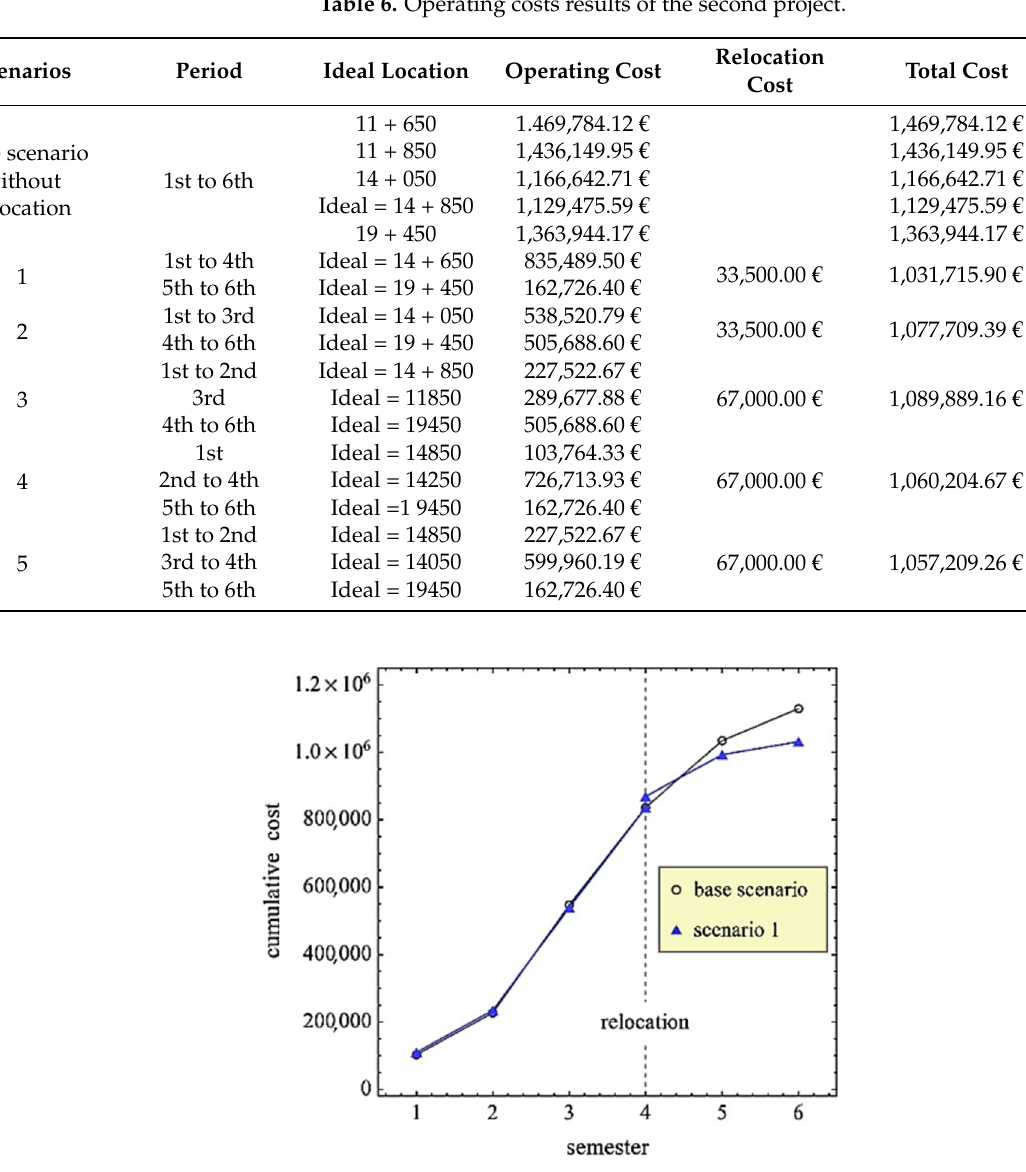
Figure 4. Comparison of cumulative costs.